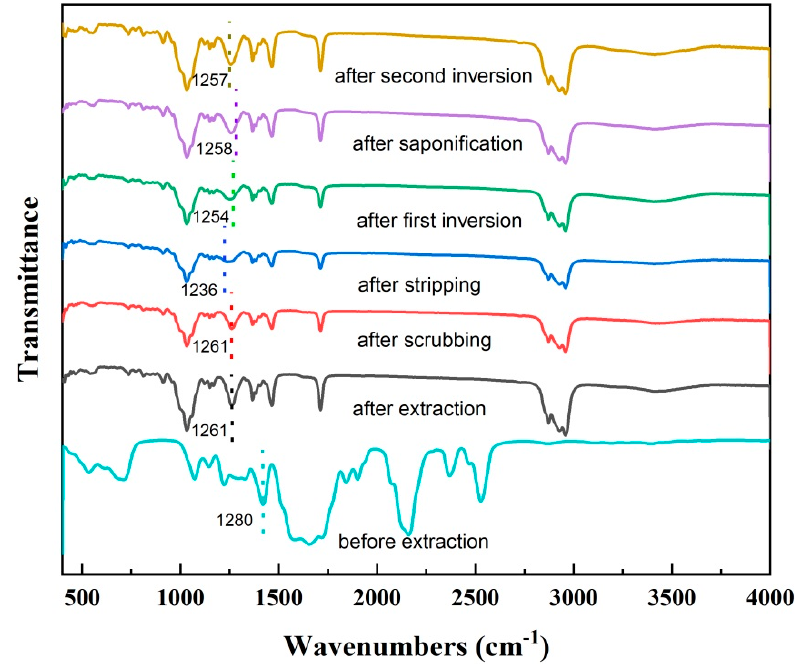
Figure 10. FTIR spectra of organic phases.